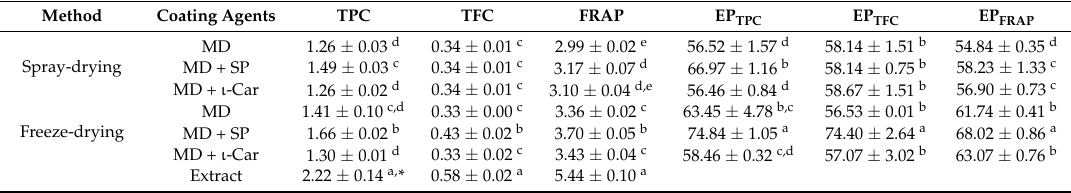
Table 3. Total phenolic content (TPC) (mg GAE/g d.b.), total flavonoid content (TFC) (mg CE/g d.b.), ferric reducing ability of plasma (FRAP) (mM TE/g), encapsulation productivity (EP %) for TPC, TFC and FRAP of the microparticles. The results were expressed as mean ± standard deviation ( n =